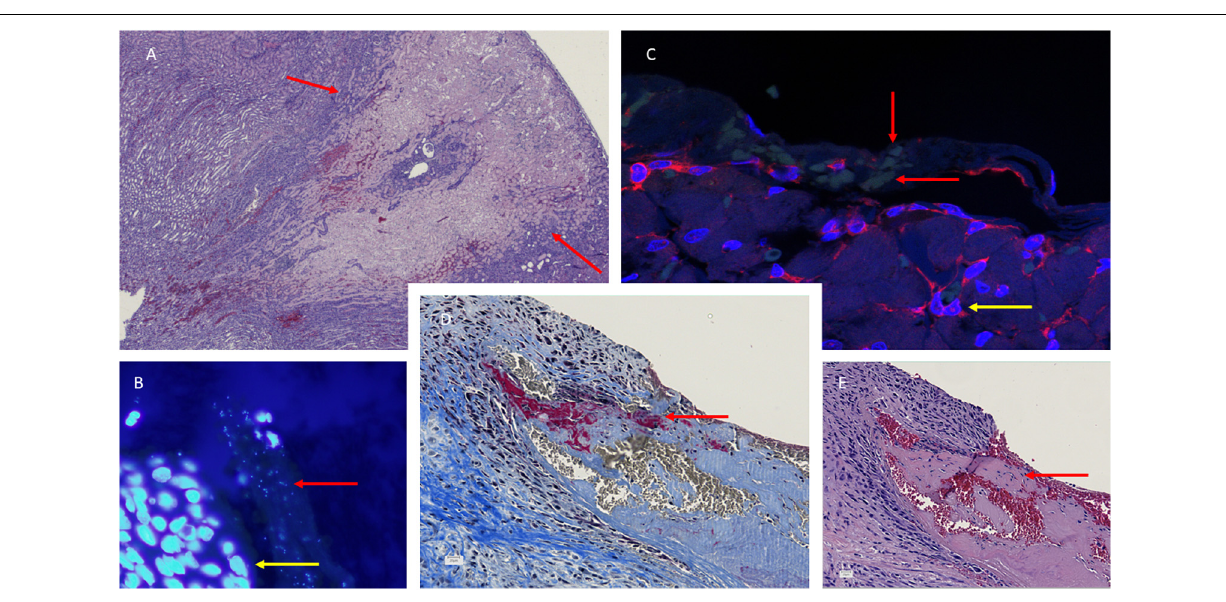
endothelium prior to bacterial challenge though a catheter